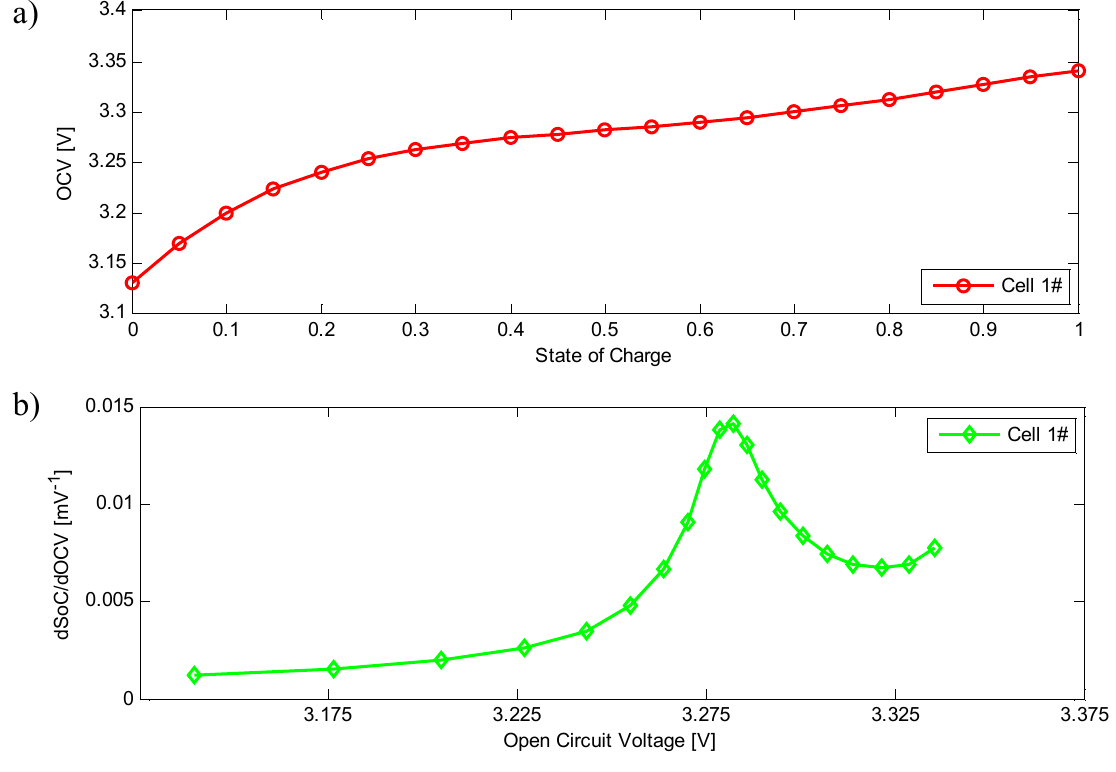
Figure 5. ( a ) The open circuit voltage (OCV) test and ( b ) incremental capacity analysis (ICA) result at temperature 25